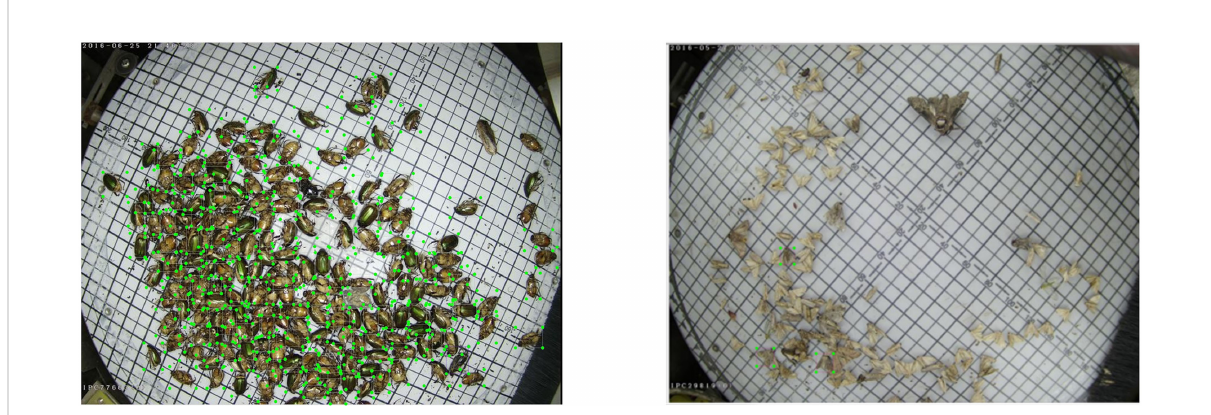
FIGURE 2 The left image shows masking and adhesion between pests. The right image shows incomplete image